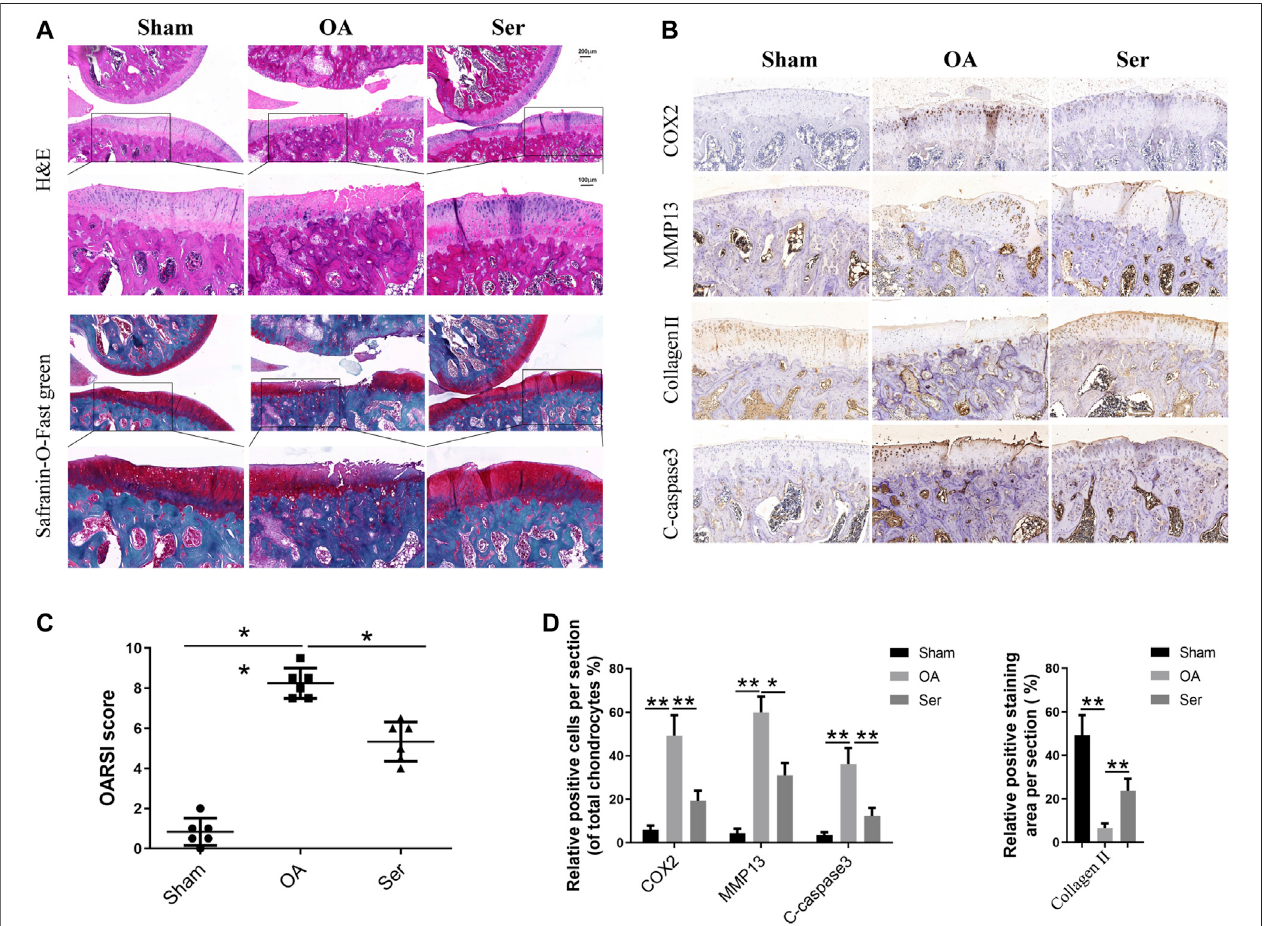
FIGURE6| SerpreventscartilagedamageinratOAmodel. (A) H&EandSafranin-O-Fastgreenstainingofcartilagesamplesfromeachgroup8weekspostsugery. (B) OARIS scores of each group. (C) Immunohistochemical staining and (D) quantitative of COX2, MMP13, collagen Ⅱ and C-caspase3 in the cartilage samples from each group. p p < 0.05, pp p <